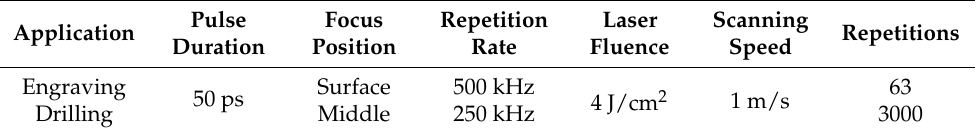
Table 2. Laser and scanning parameters for silicon patterning.